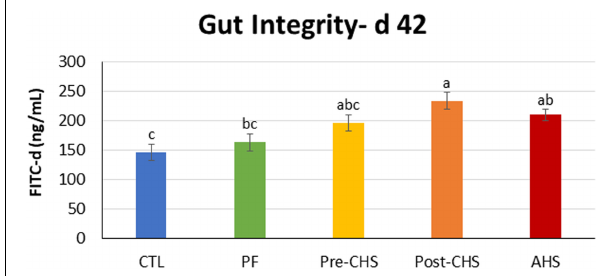
FIGURE 3 | FITC-d concentration in the serum of Cobb 500 male broiler chickens on day 42. Birds in all the groups were raised under the recommended conditions from day 0 to 28. On day 42, birds fasted for 2 h, then individually weighed and orally gavage with 8.32 mg FITC-d/kg body weight, and blood was collected 2 h post gavage. Treatments include: (1) control (CTL): birds raised under thermoneutral condition (23 ◦ C) from day 29 to 42; (2) AHS: birds raised under thermoneutral condition (23 ◦ C) from day 29 to 42, but exposed to 2 h AHS (35 ◦ C) before sampling on day 42; (3) Pre-CHS: birds exposed to high ambient temperature (35 ◦ C) for 8 h/day (9:30 am–5:30 pm) from day 29 to 42, and sampled before starting the CHS; (4) Post-CHS: birds exposed to high ambient temperature (35 ◦ C) for 8 h/day (9:30 am–5:30 pm) from day 29 to 42, and sampled 2 h after starting the CHS; (5) pair-fed (PF): birds raised under thermoneutral condition (23 ◦ C) from day 29 to 42, but pair-fed to CHS group (these birds received each day 1.05 times the average feed intake recorded in the CHS group in the previous day). Results are given as means ( n = 8; two birds/pen) for each group. Error bars indicate standard errors. Columns with different letters are significantly different ( P <